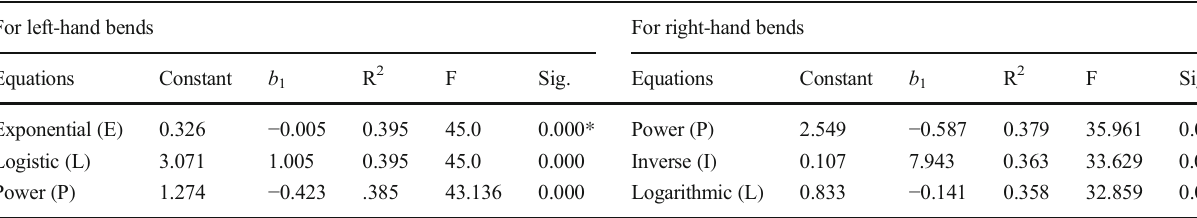
Nonlinear regression models for the effect of curve radius on TTR For left-hand bends For right-hand bends